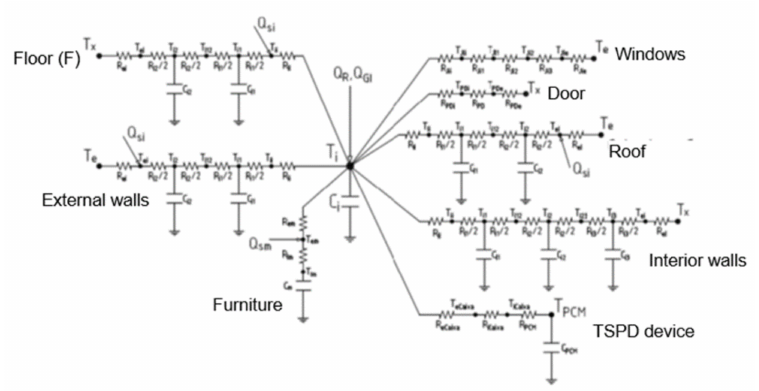
Figure 5. RC model of the room + Portable Device for Indoor Temperature Stabilization (PoDIT) device [24]. Q si represent solar incidence on the floor and external walls, Q GI the internal gains and Q R the heat gains or losses due to ventilation / air